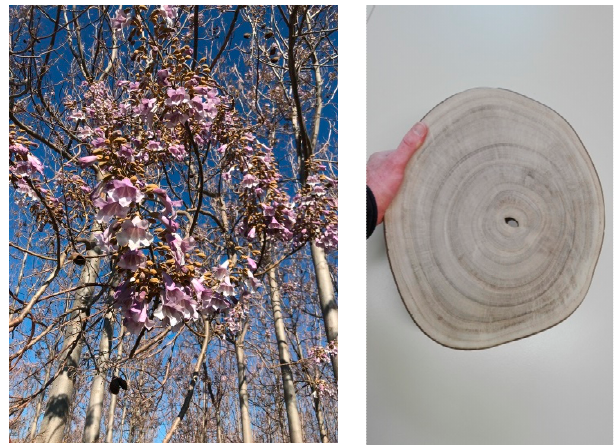
Figure 5. Paulownia tree cultivated at the Campus Klein-Altendorf, Germany. Copyright 2019, Georg Völkering.